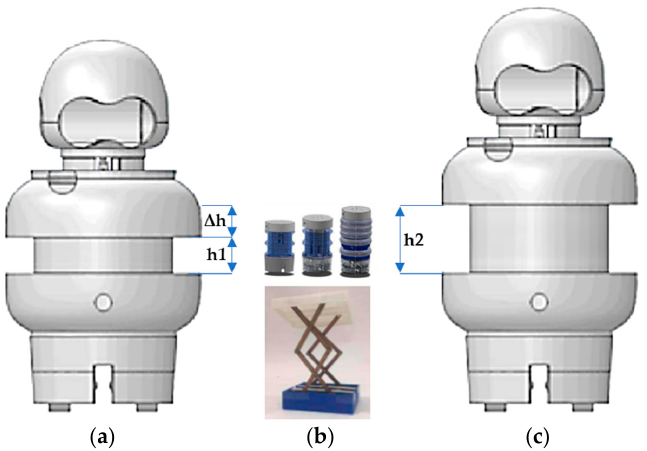
Figure 8. Robot growth implementation: ( a ) height from h1 and intent of extension of Δ h ( b ) implementation of Δ h with wrinkled tube including scissor jack structured inside and ( c ) after the physical growth of Δ h up to h2.